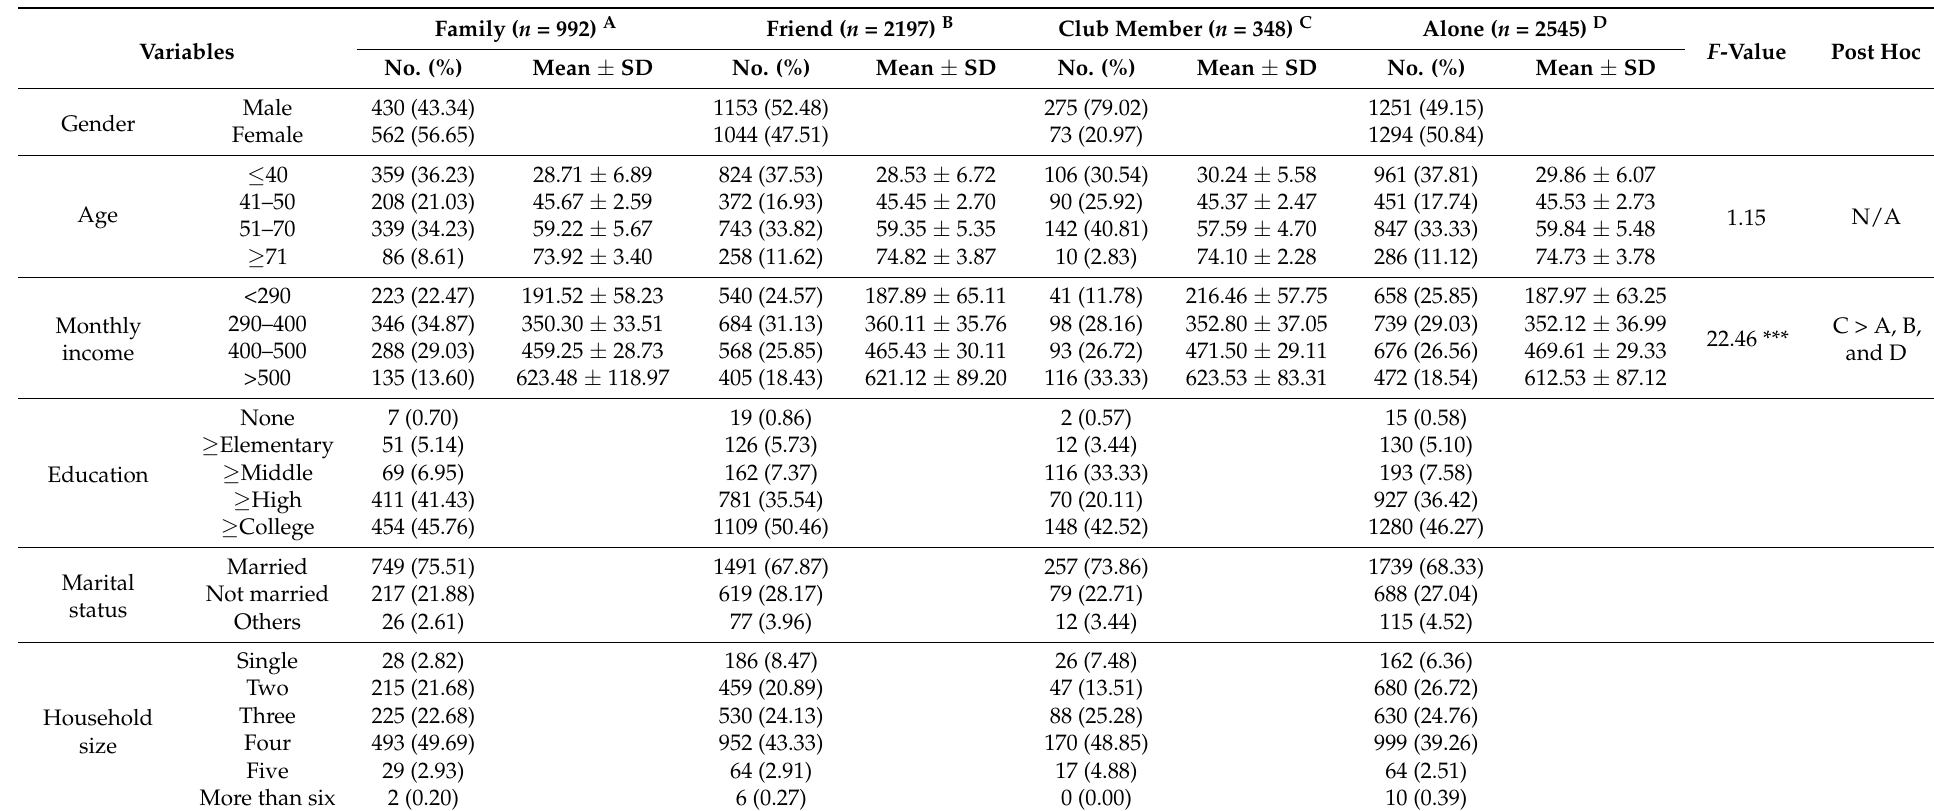
Table 1. Characteristics for participants in four